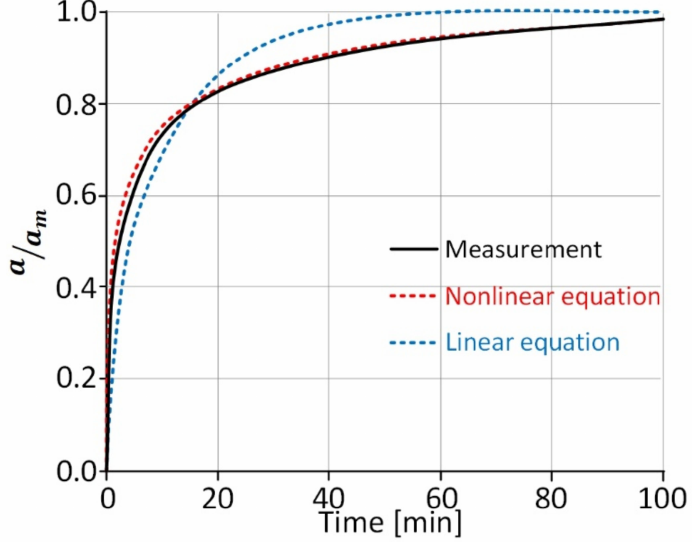
Figure 3. Comparison of the linear and nonlinear solution of the diffusion equation with the experimental result—example for a sample of hard coal with a grain size of 90–100